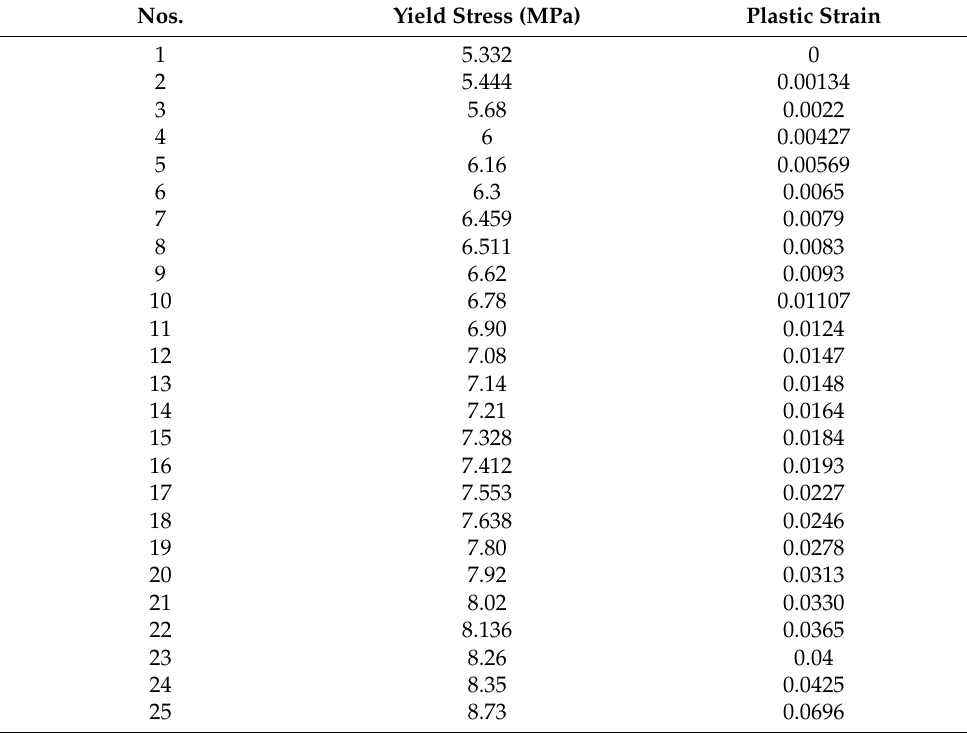
Table A2. Yield stress and plastic strain of LDPE.